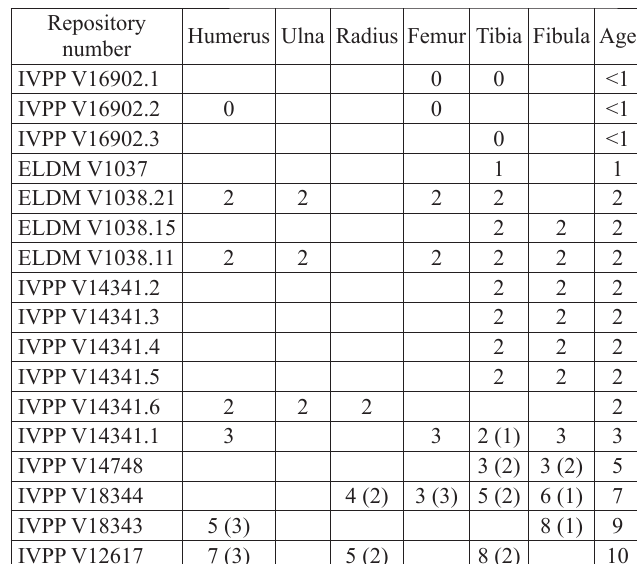
Table 1. Numbers of LAGs in individual thin sections made during this study. Values in parentheses represent additional LAGs that are inferred to have been obliterated by expansion of the medullary cavity. An age estimate is given for each specimen, based on the evidence from all thin sections taken for that specimen. For IVPP V12617, the cross-section through the radius suggests a younger age (seven years) than cross-sec- tions through the other sampled bones (ten years). However, only one juvenile radius was sectioned in this study, and it is possible that we have underestimated the number of LAGs obliterated by medullary cavity expansion in the radius of IVPP